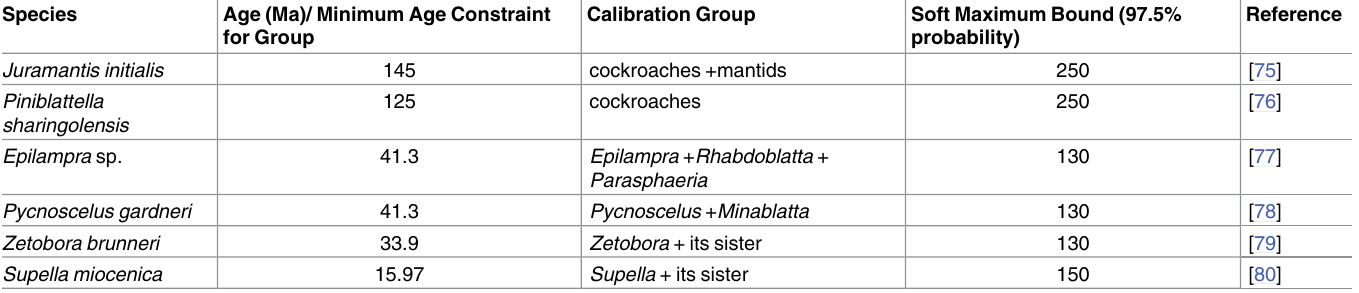
Species Age (Ma)/ Minimum Age Constraint for